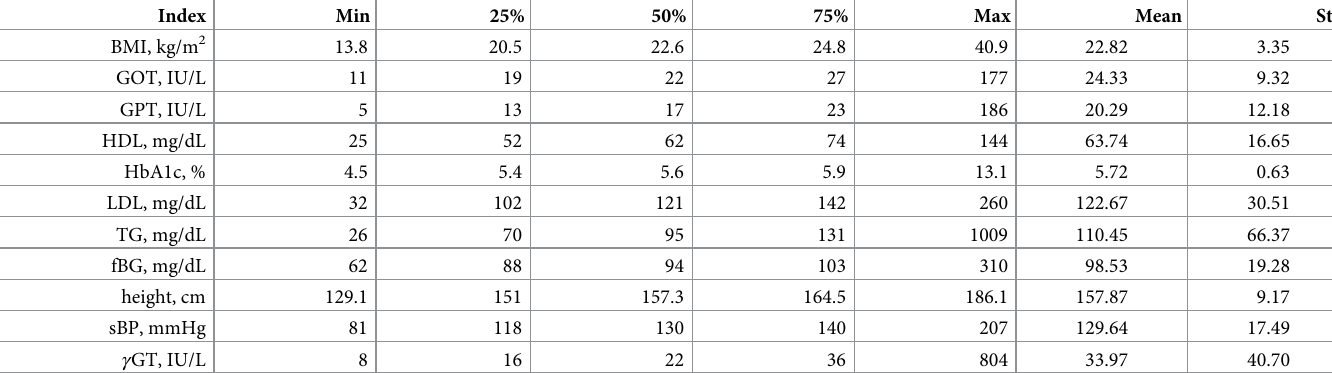
Table 1. Percentile values of respective indexes, with minimum, maximum, mean values, and standard deviations.